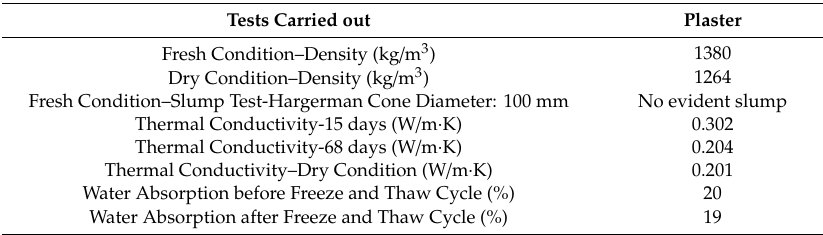
Table 7. Physical tests’ results on